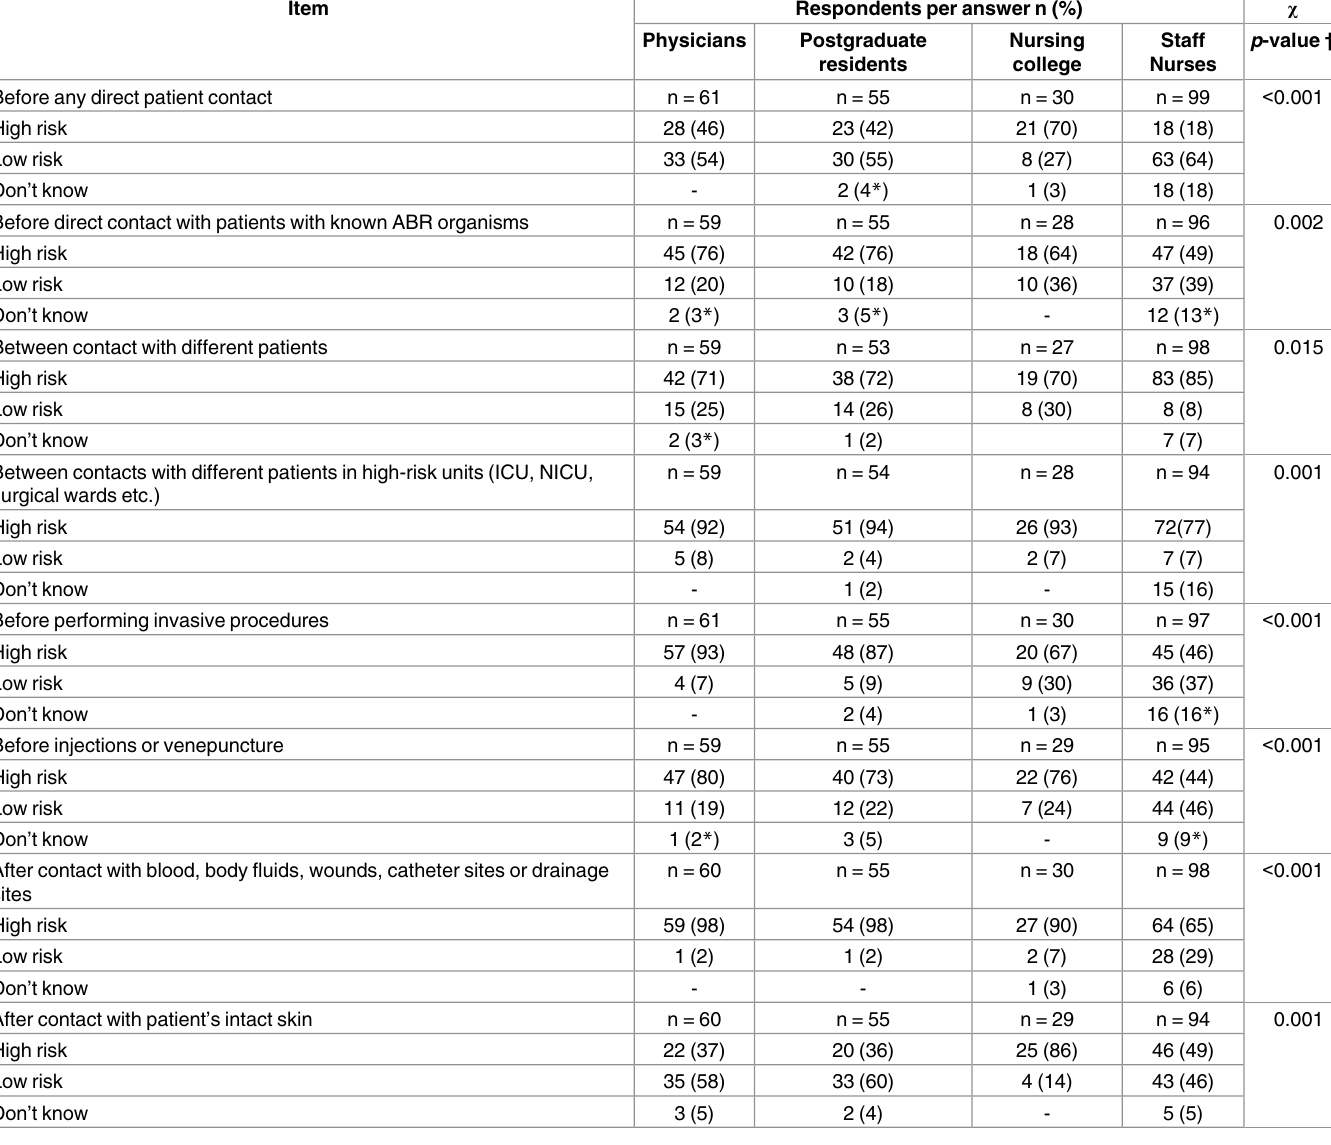
Table 5. Perceivedrisk of transmission of infectious agents according to respondent study groups in study setting.